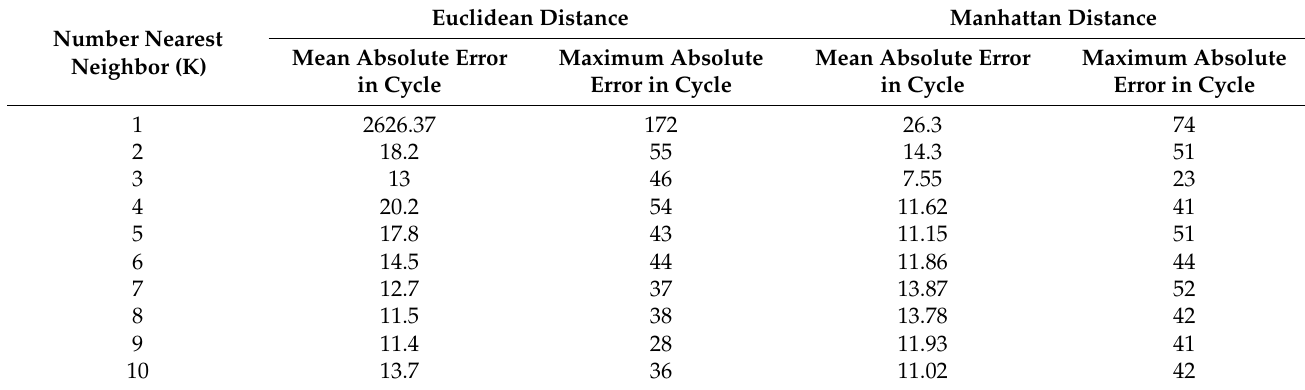
Table 20. Comparison results of FEM and KNN models on 1296 training datasets.